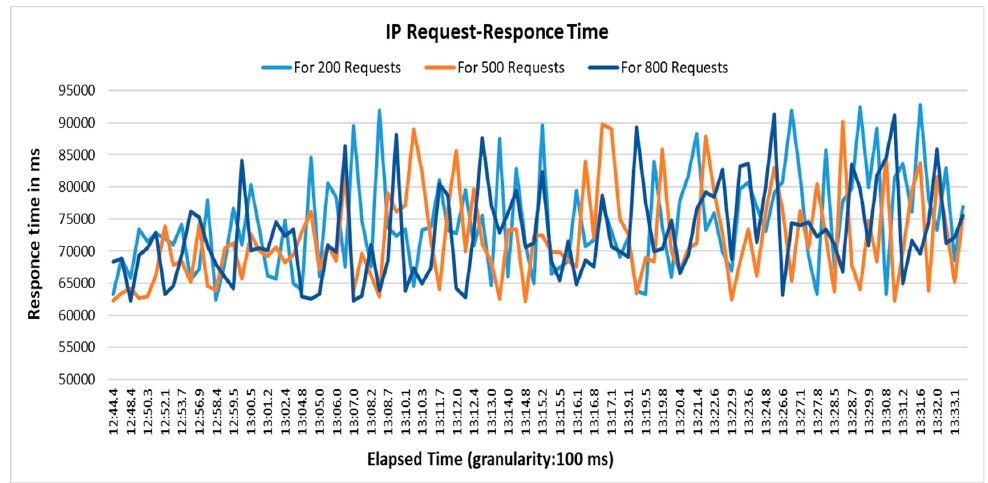
Figure 17. IP address response time for a different simultaneous request.